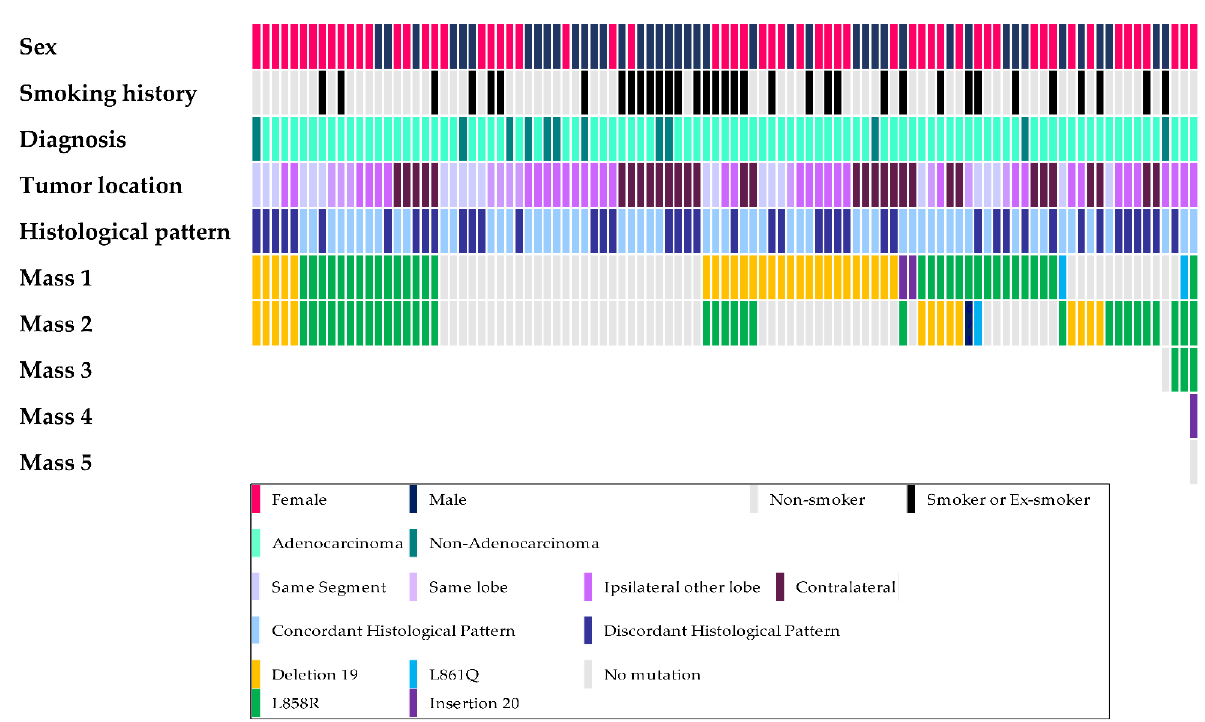
Figure 1. Schematic demonstration of the clinicopathological parameters and EGFR mutation.